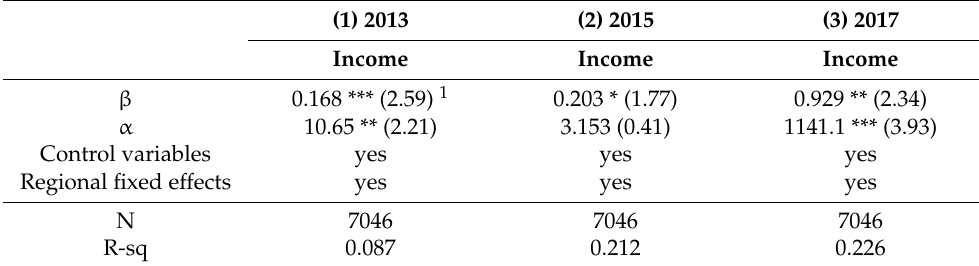
Table 4. Ordinary least squares (OLS) regression results of financial cognitive level on rural household